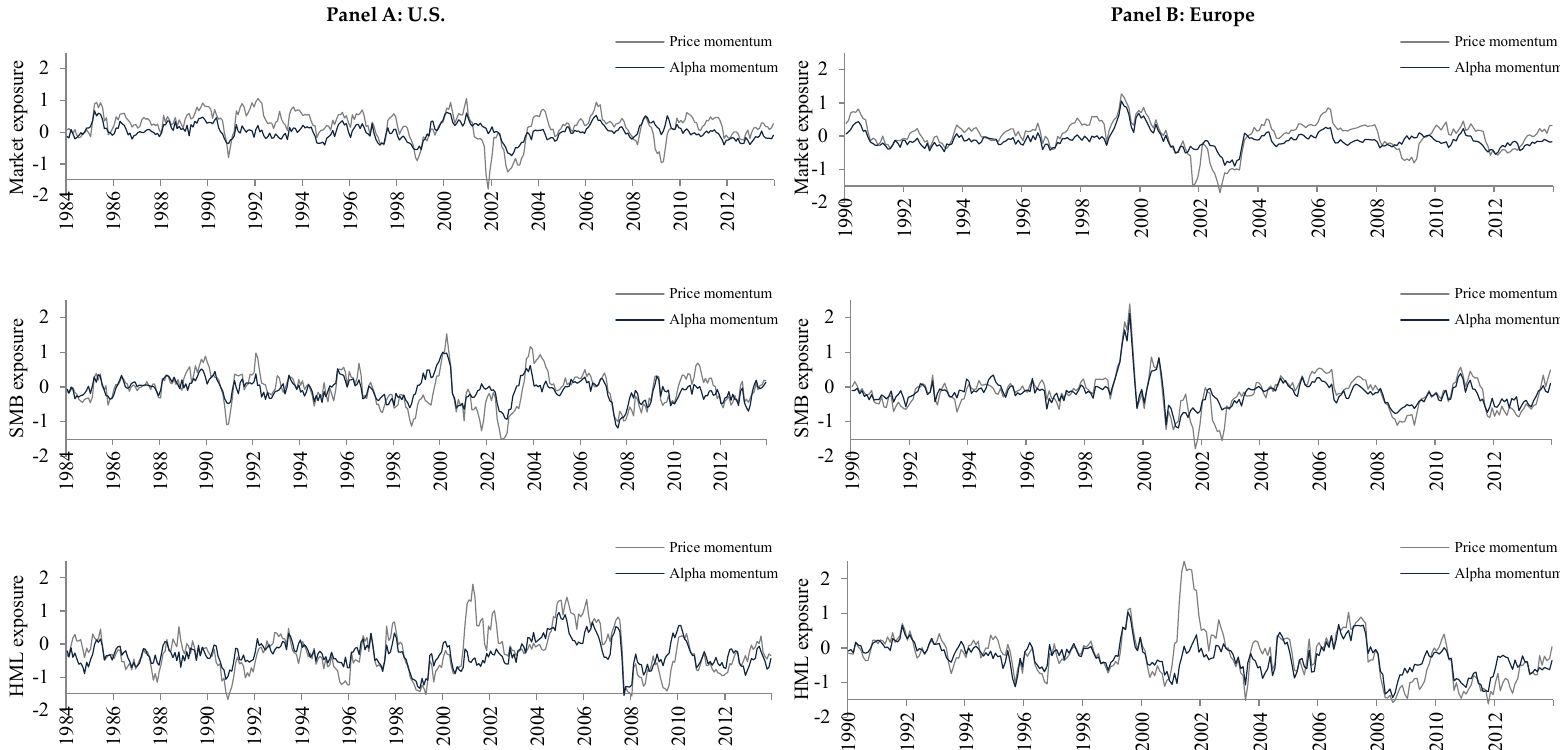
Figure 2. This figure shows the factor exposures of price momentum and alpha momentum over time for a twelve-month formation period and a one-month investment period. Factor loadings are calculated as the average factor exposures of the stocks in the respective momentum portfolios based on daily data over six months beginning with the investment month. Results are presented in Panel A for the U.S. from January 1984 to December 2013 and in Panel B for Europe from January 1990 to December 2013.